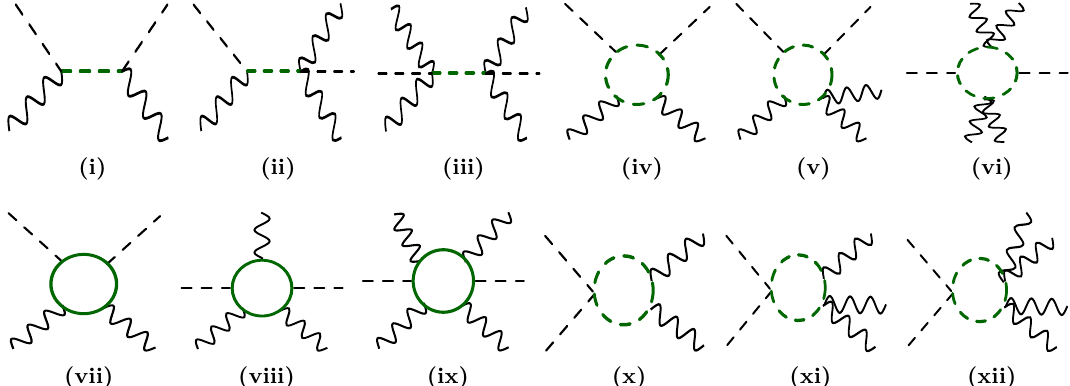
Figure 7 . Tree- (i)–(ii) and one-loop-level (iii)–(viii) diagrams built of Lorentz invariant renormal- izable interactions of the UV theory that lead to effective operators of φ 2 X 2 class.